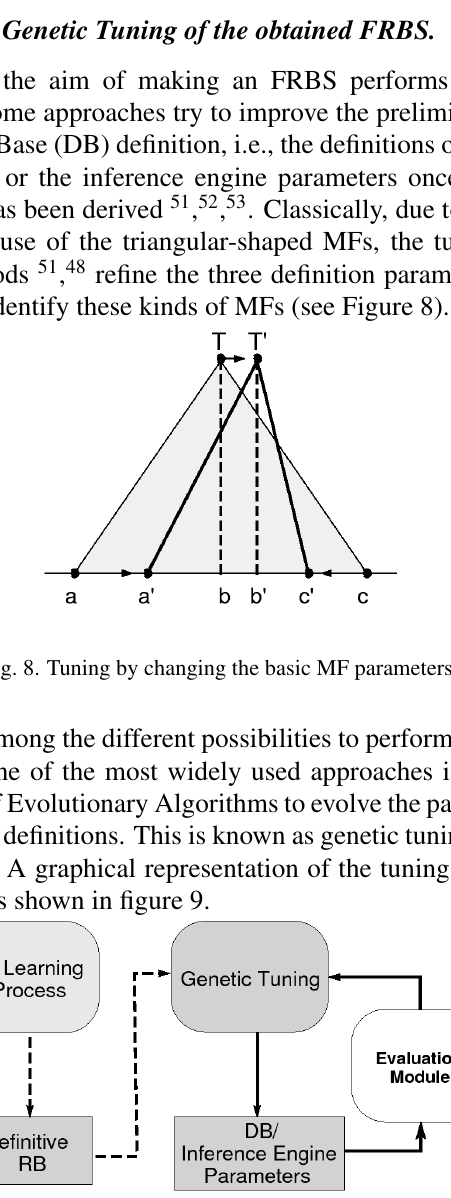
Fig. 9. Genetic tuning